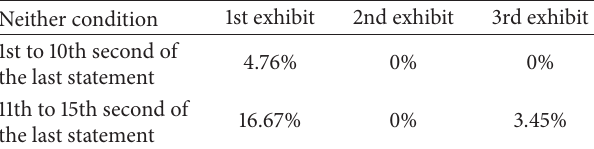
Table 4: Disengagement of the subjects from the exhibits in the Neither